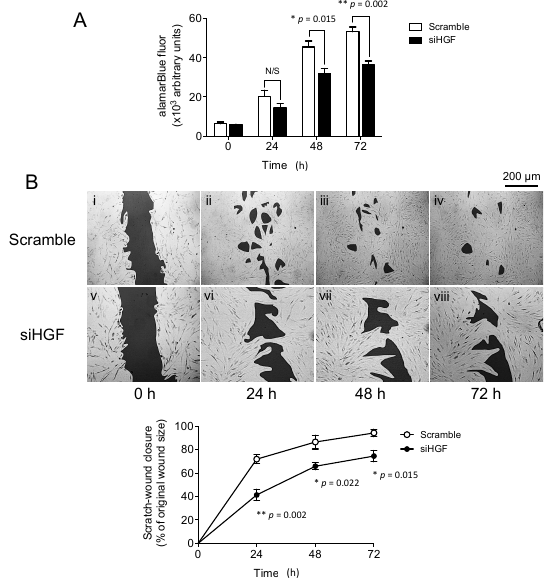
Figure 1. Hepatocyte growth factor (HGF) knockdown is detrimental to oral mucosal fibroblast (OMF) cell function. siHGF (solid bars/lines)- and scrambled siRNA (open bars/lines)-transfected, OMFs were assessed for effects on ( A ) proliferation and ( B ) in vitro scratch wound repopulation. Time-lapse images are representative of 3 independent scratch wound experiments (scale bar = 200 µ m, original magnification 100×). Data is shown as mean ± standard error (S.E.) for n = 3 independent experiments (* p ≤ 0.05, ** p ≤ 0.01, vs. serum-free F-SCM controls; N/S, no significance).